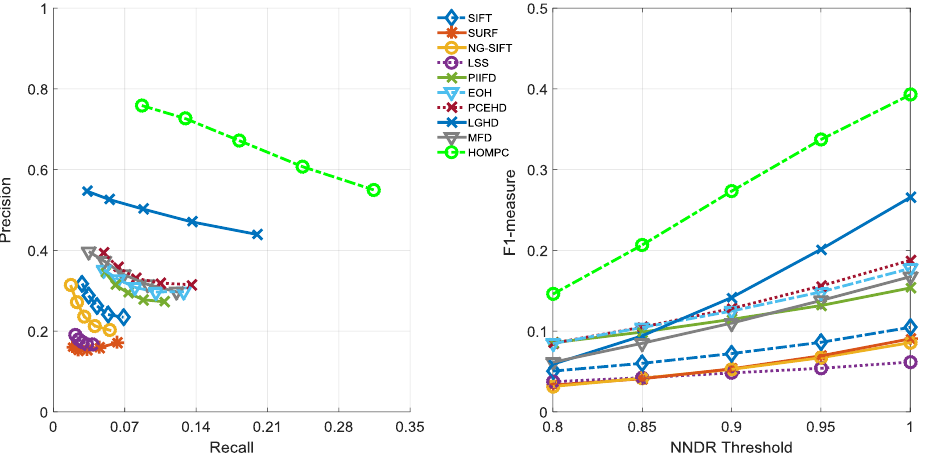
Table 5. AUCPR (%) results for all the descriptors.